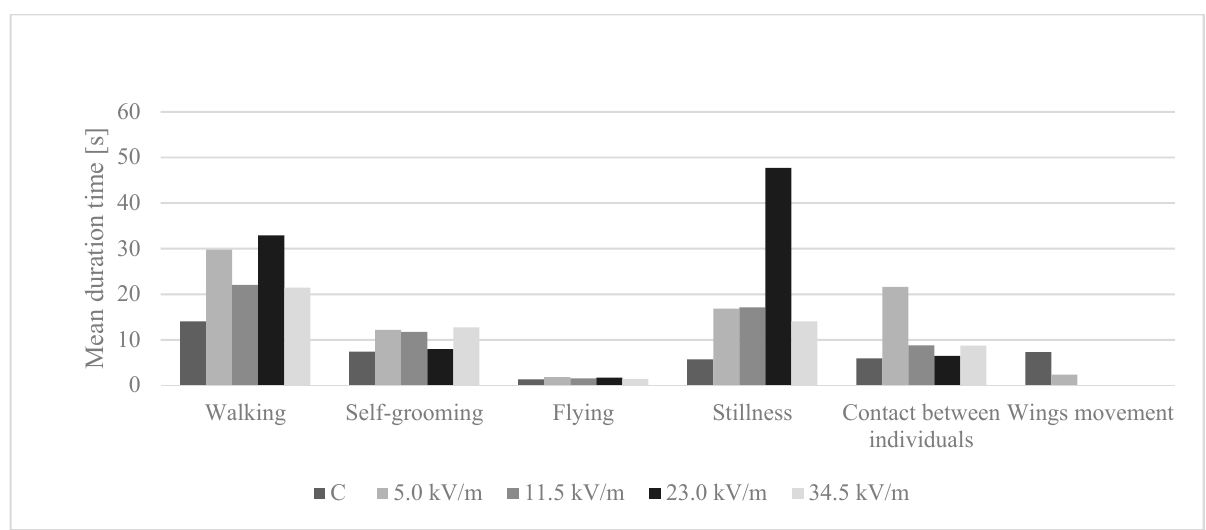
Figure 3. Average time spent on behavior by bees after 12 h under the influence of an E-field at 50 Hz and an intensity of 5.0 kV/m, 11.5 kV/m, 23.0 kV/m, or 34.5 kV/m. The group name is the E-field intensity to which the bees were exposed. The control group is marked with the letter C. Table 2. Comparison of the number of behavior occurrences between all groups.